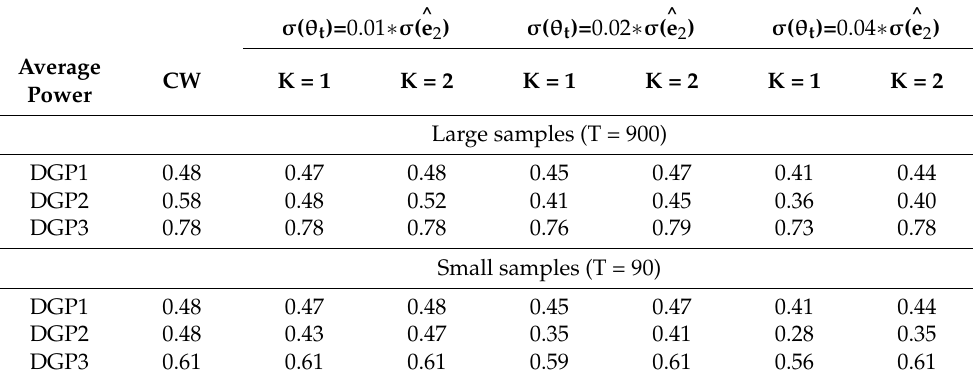
Table A2. Summary of power comparisons between CW and WCW tests with nominal size of 5% for our three